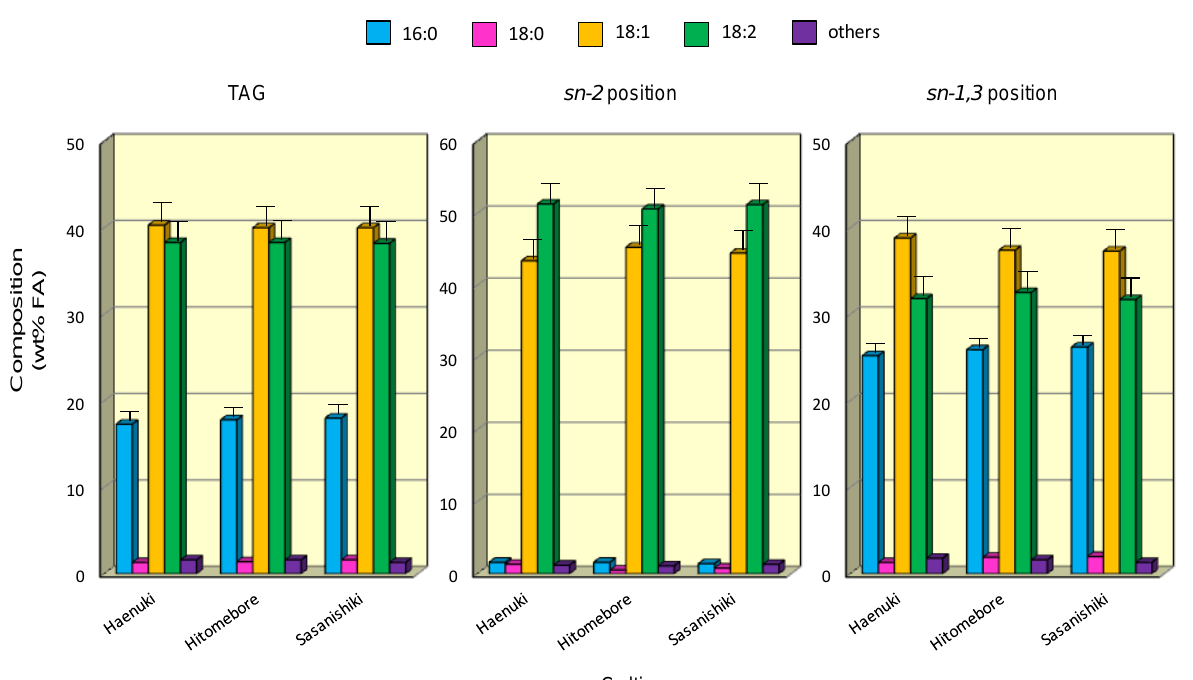
Figure 4. Composition and positional distribution of FA in TAG prepared from rice brans. Each value represents the average of three determinations, and vertical bars depict the mean and standard deviation. “Others” include minor FA such as 14:0, 16:1, 18:3 and 20:0. For abbreviations, see Figure